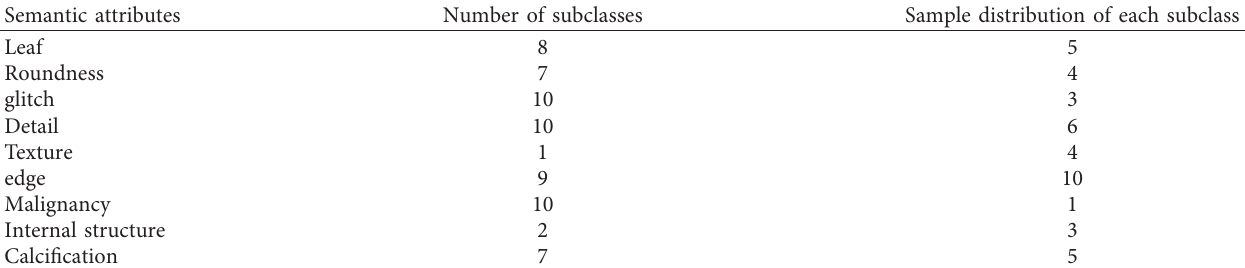
Table 1: Sensory field size and step length [22].